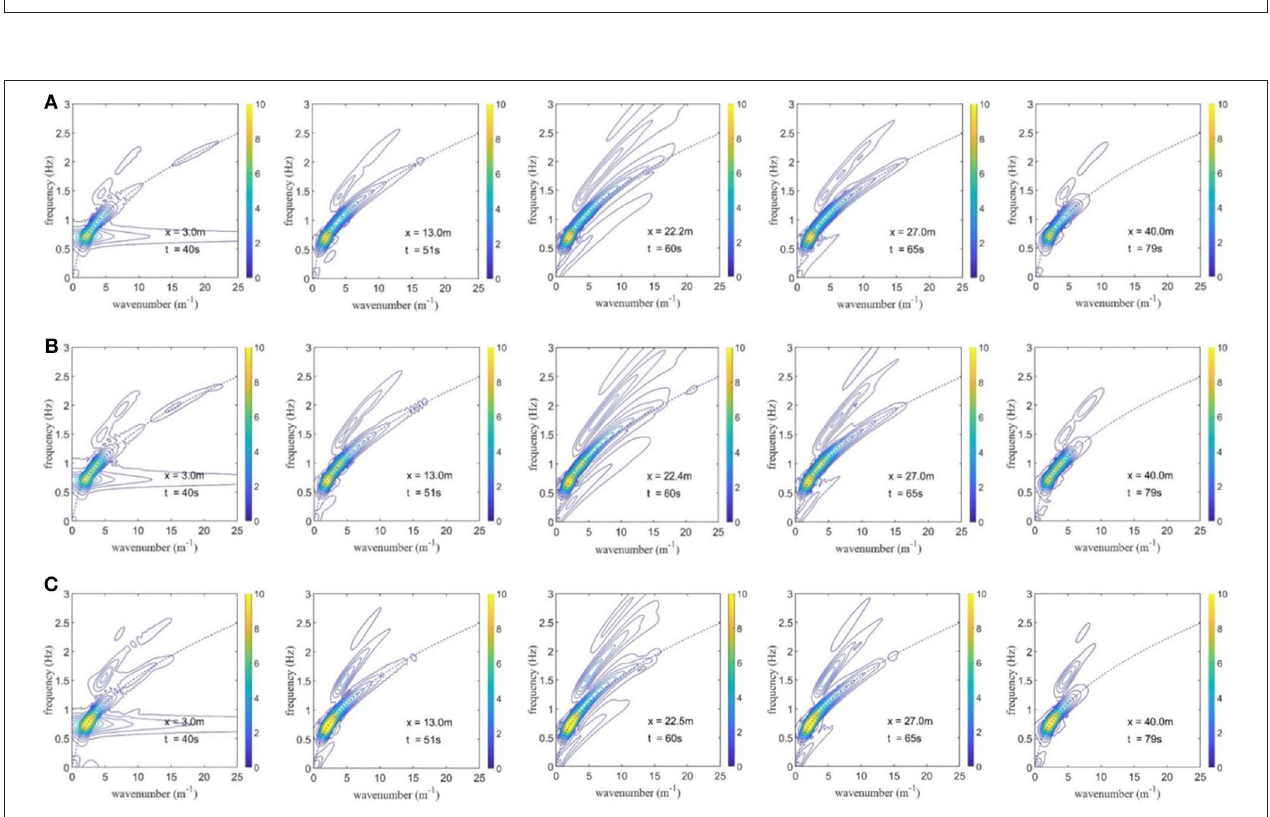
FIGURE 13 | Wavenumber-frequency spectra at typical locations along the numerical wave tank (blue dashed lines indicate the linear dispersion relationship). (A) Case 1_AB, (B) Case 2_AB, (C) Case 3_AB.